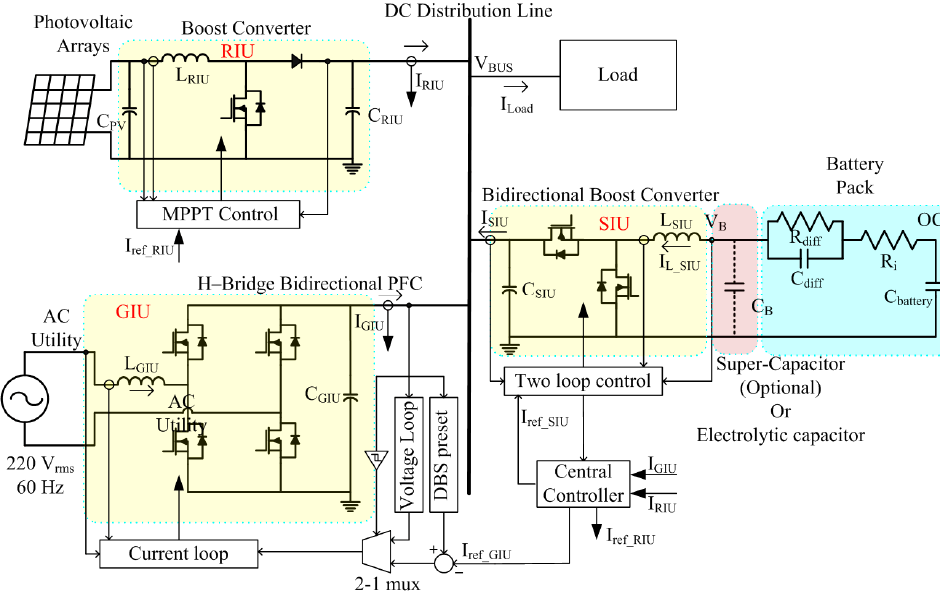
Figure 7. System architecture of the proposed DC distribution system. Table 1. Hardware specification .